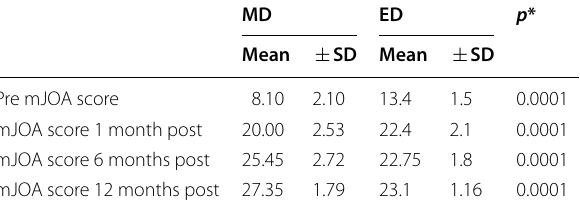
Table 5 Comparison between the 2 study groups as